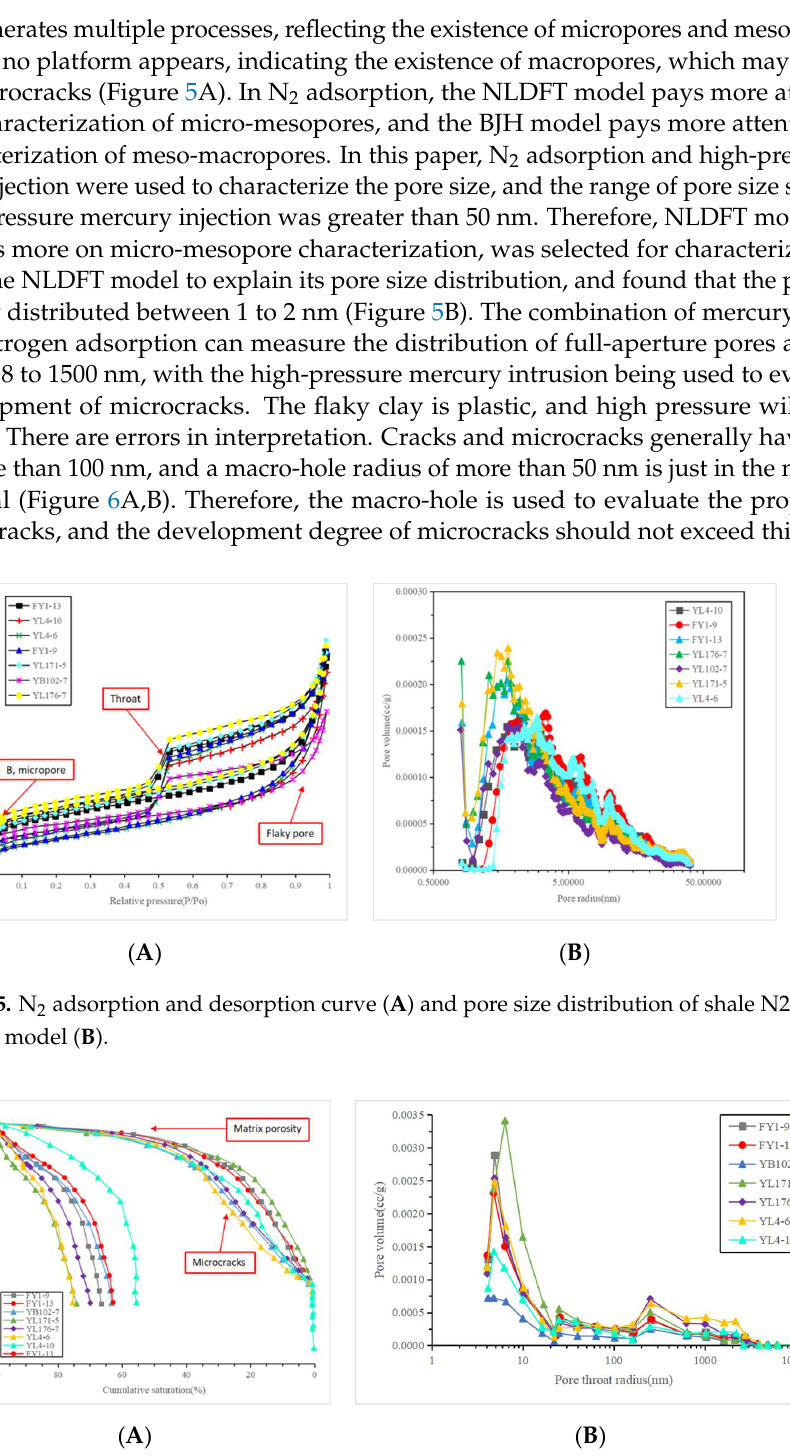
Figure 6. The curve of mercury intrusion volume with pressure in high pressure mercury intrusion ( A ) and pore size distribution explained by high pressure mercury injection ( B